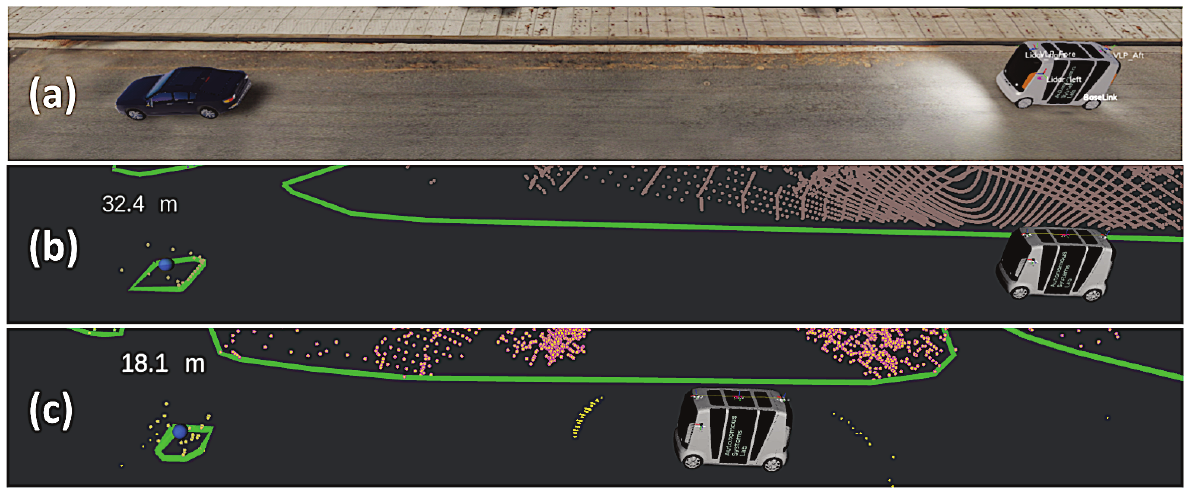
Fig. 7. Maximum distance for detecting a stopped NPC after filtration with different filtering parameters.